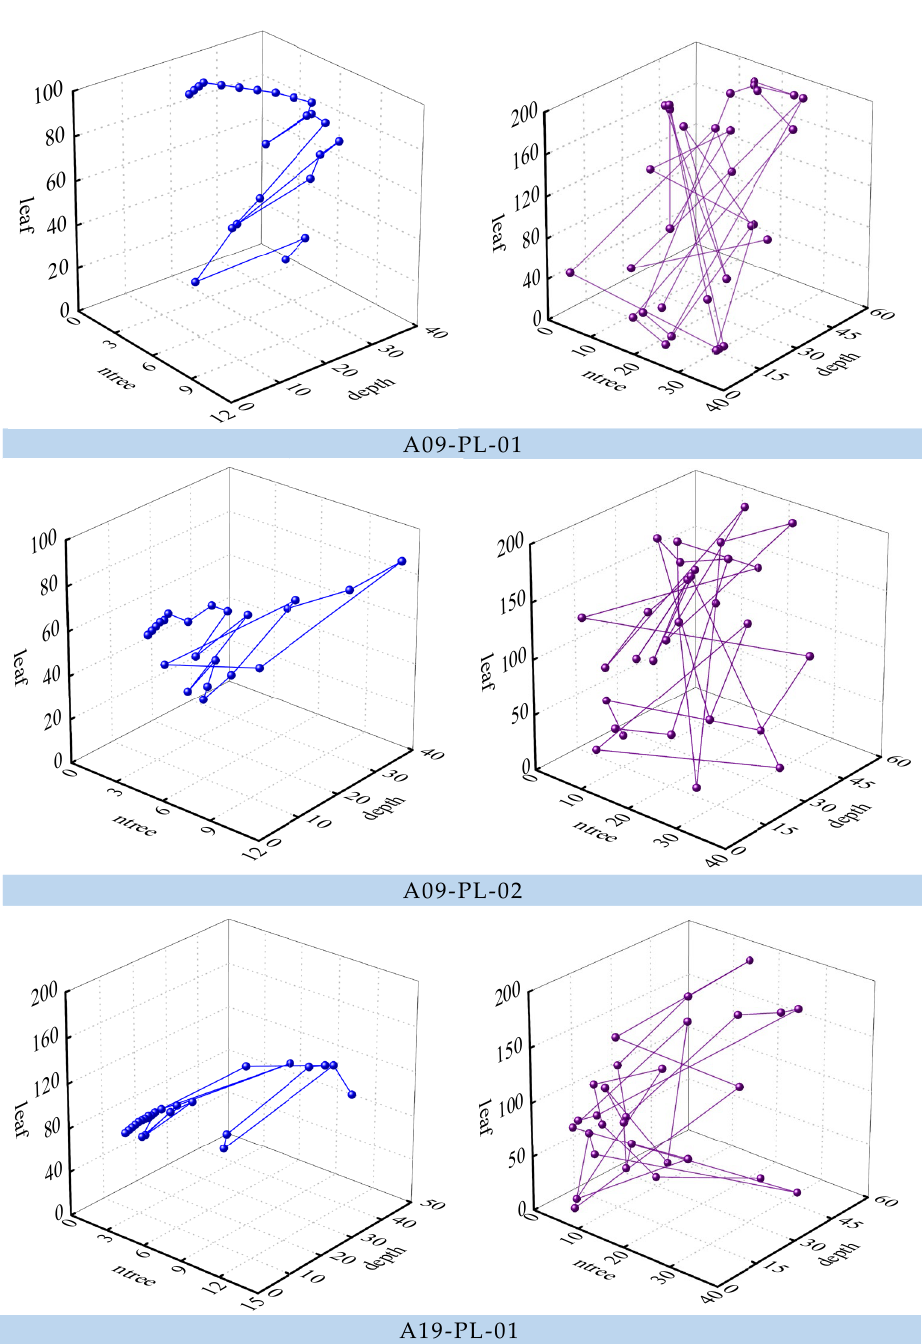
Figure 8. The displacement and residual error plot with Savitzky - Golay de - noising or wavelet de - noising on A09 - PL - 01.